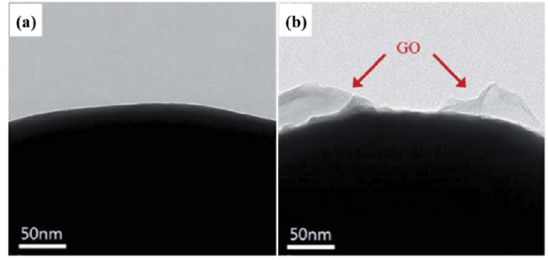
Figure 7. TEM images of ( a ) silica and ( b ) GO coated silica [68].